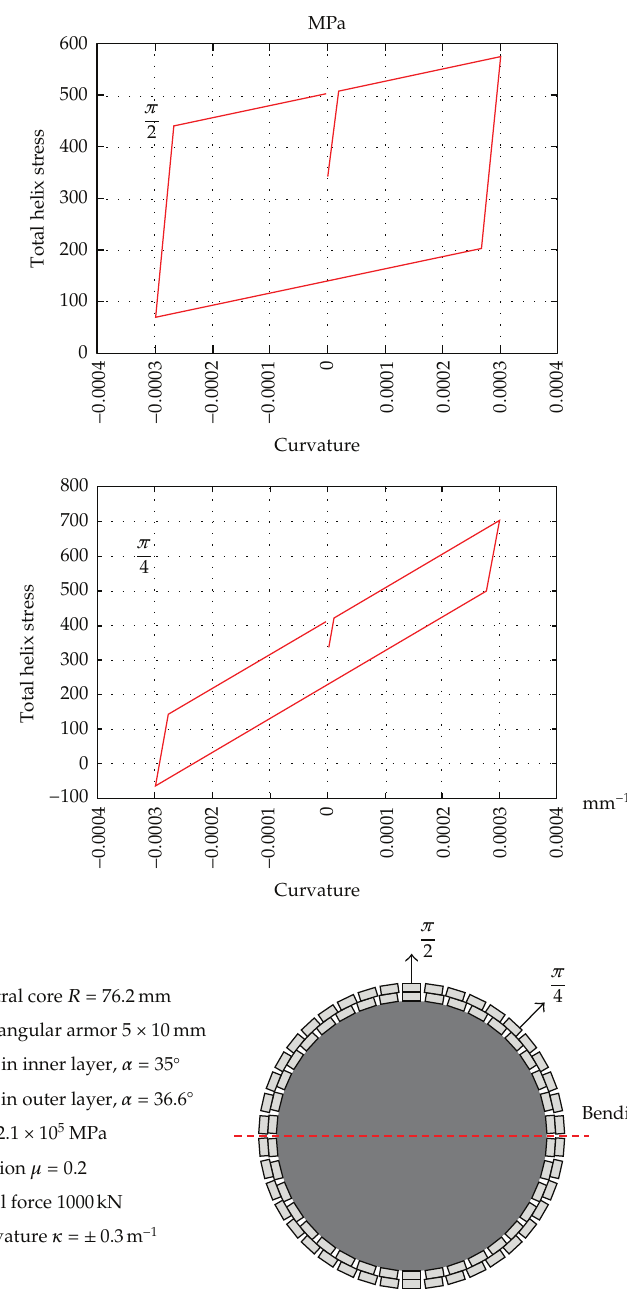
Figure 10: Performance of the bending hysteresis